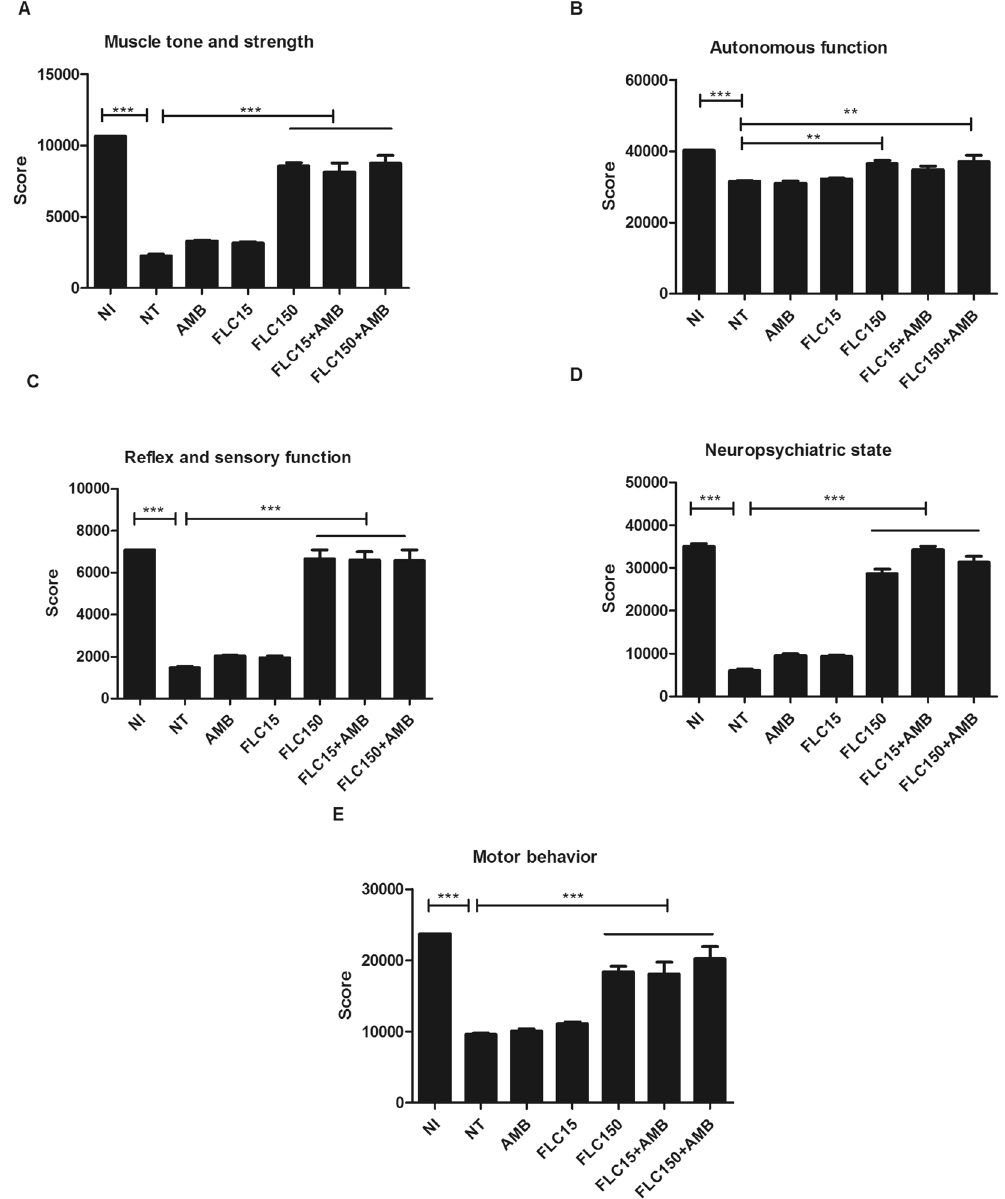
Figure 3. Behavioral profile evaluation (SHIRPA protocol) of animals infected with C. gattii and treated with amphotericin B (AMB), fluconazole (FLC15 and FLC150) and the combination FLC15 + AMB and FLC150 + AMB ( A–E ). ( A ) Muscle tone and strength; ( B ) autonomous function; ( C ) Reflex and sensory function ( D ) neuropsychiatric state; ( E ) motor behavior. NI (not infected); NT (Control, untreated), AMB (Amphotericin B 0.5 mg/kg/day), FLC15 (Fluconazole 15 mg/kg/day), FLC150 (Fluconazole 150 mg/kg/day) FLC15 + AMB (Fluconazole 15 mg/kg/day + Amphotericin B 0.5 mg/kg/day), FLC150 + AMB (Fluconazole 150 mg/kg/day + Amphotericin B 0.5 mg/kg/day). ** P < 0.01 *** P < 0.001 (difference when compared to